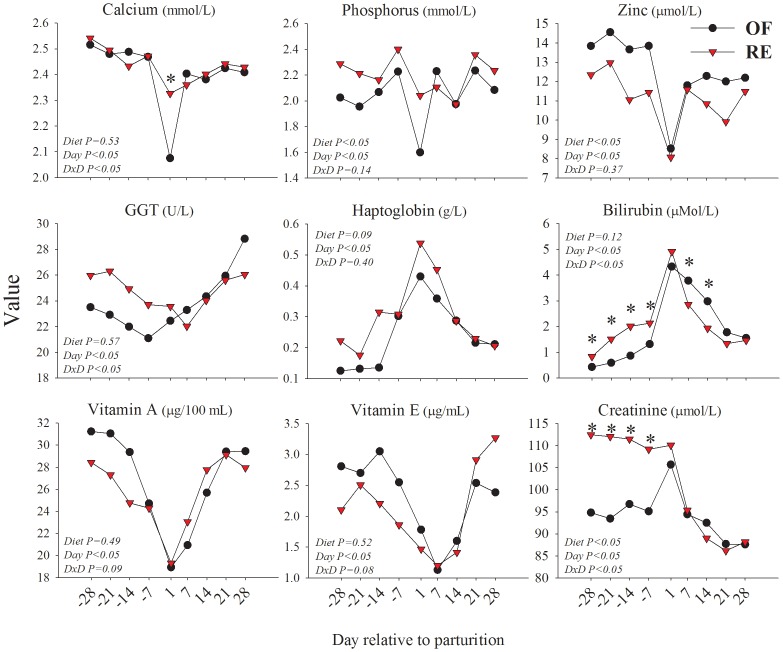
Results of plasma parameters significantly affected (P<0.05 or tendency P<0.10) by prepartal dietary energy level (OF  =  overfed energy and RE  =  restricted-fed energy prepartum) or diet × time interaction.*Difference between treatments at each time point. The GGT and Haptoglobin were log2-transformed while Bilirubin and Vitamin E were square root transformed before statistical analysis and back-transformed for plotting due to non-normal distribution.